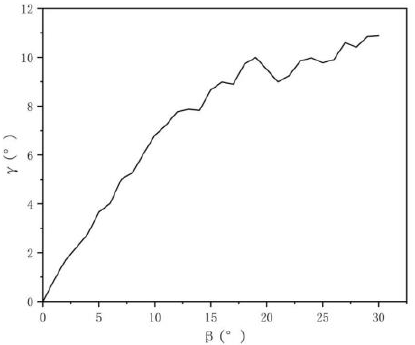
Figure 19. Rebound compensation value image.